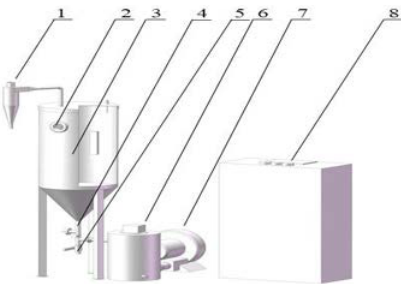
Figure 2. Schematic diagram of IR-SBD device. (1) Cyclone separator, (2) observation window, (3) dry container, (4) temperature sensor, (5) discharge hole, (6) preheating tank, (7) axial flow fan, (8) control system.